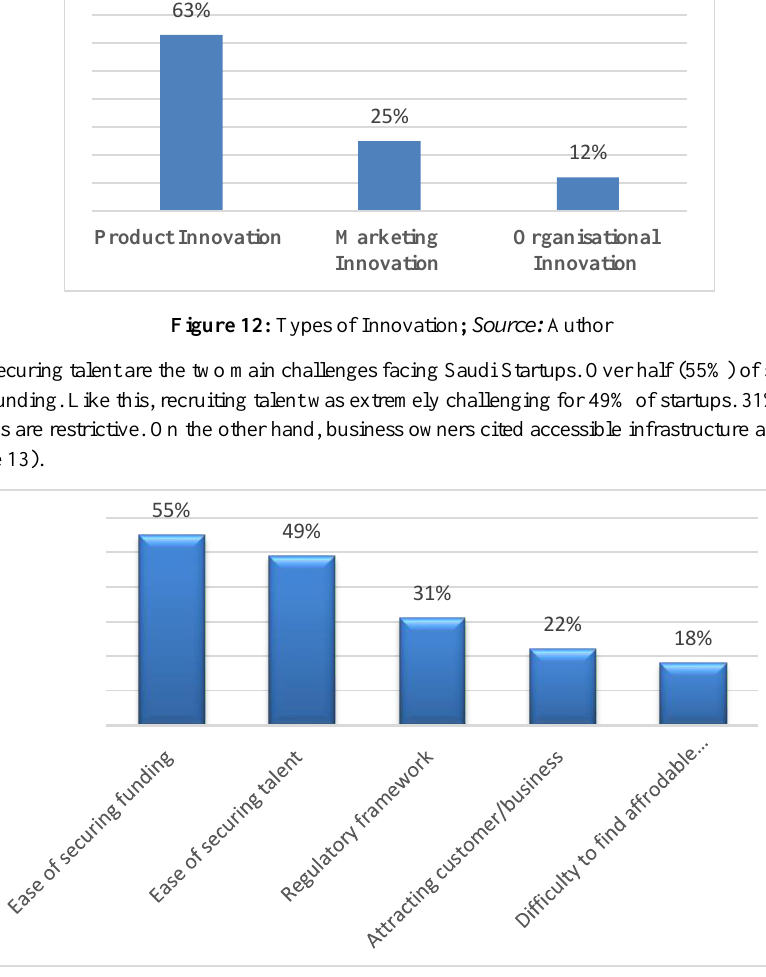
Figure 13: Challenges Facing Saudi Startups ; Source: Author